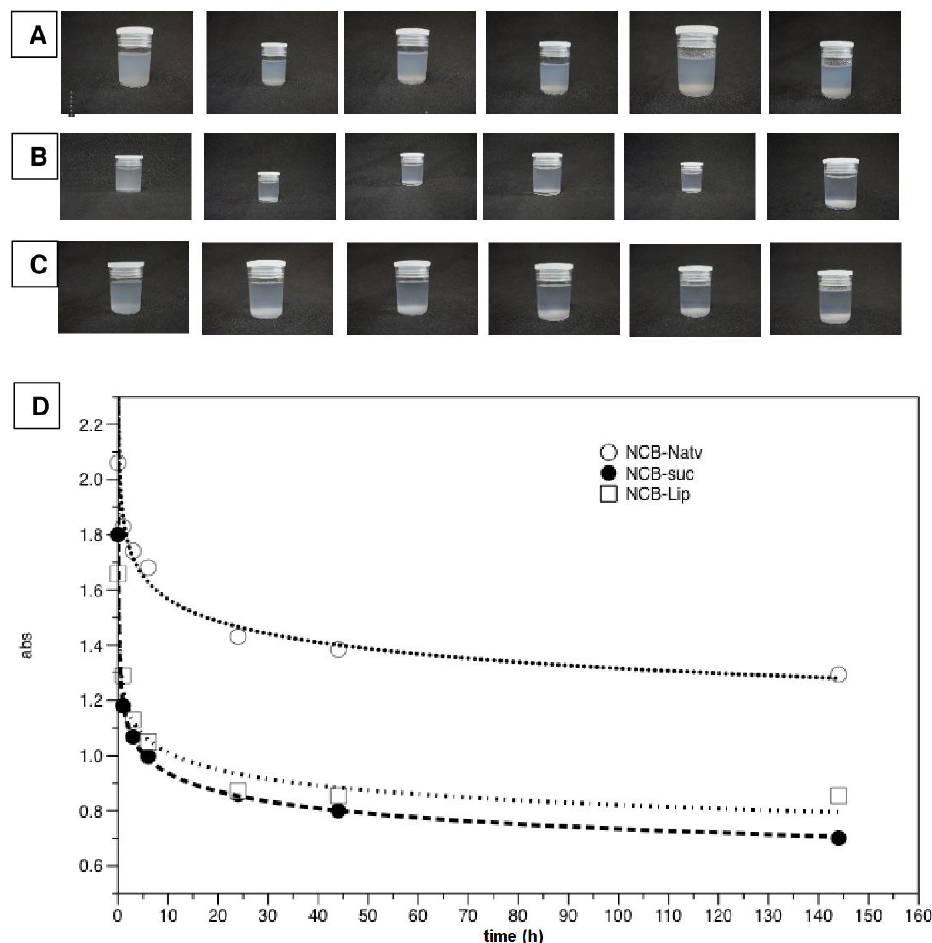
Figure 8. Photographs of suspensions in relation to time (1h, 3h, 6h, 24h, 144h). A: NCB. B: NCB-Suc. C: